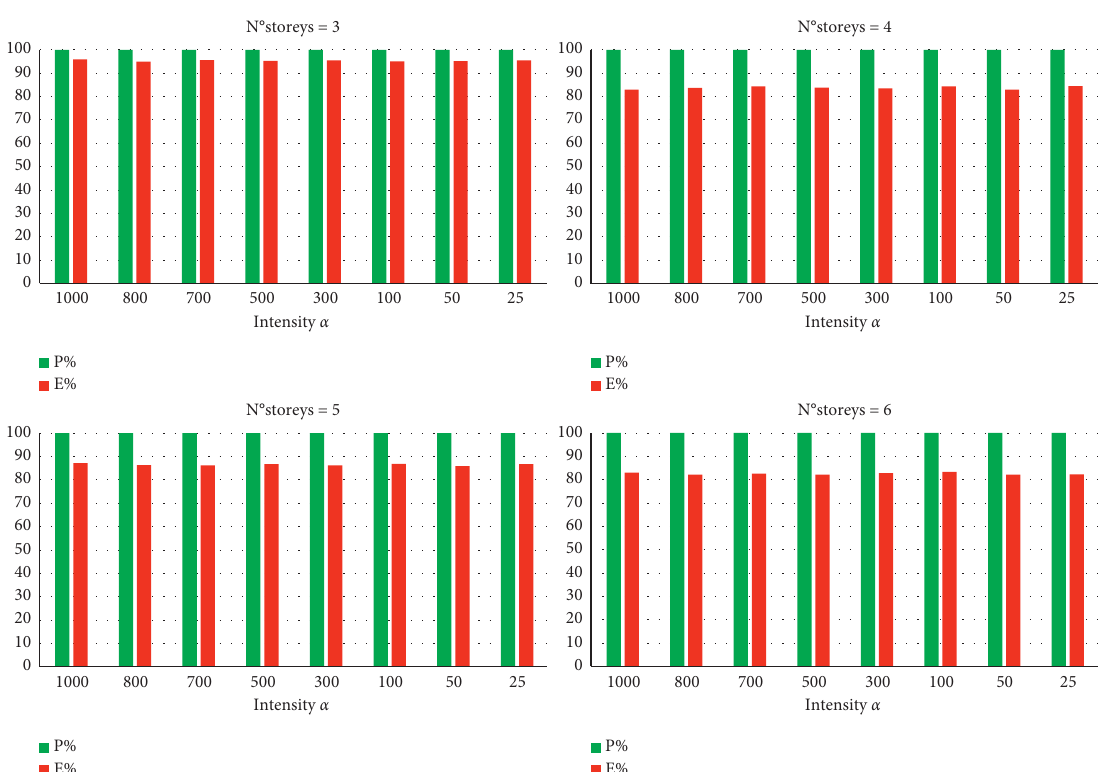
Figure 15: P% and E% for each analysed frame with assigned damage location 4 and variable intensity.